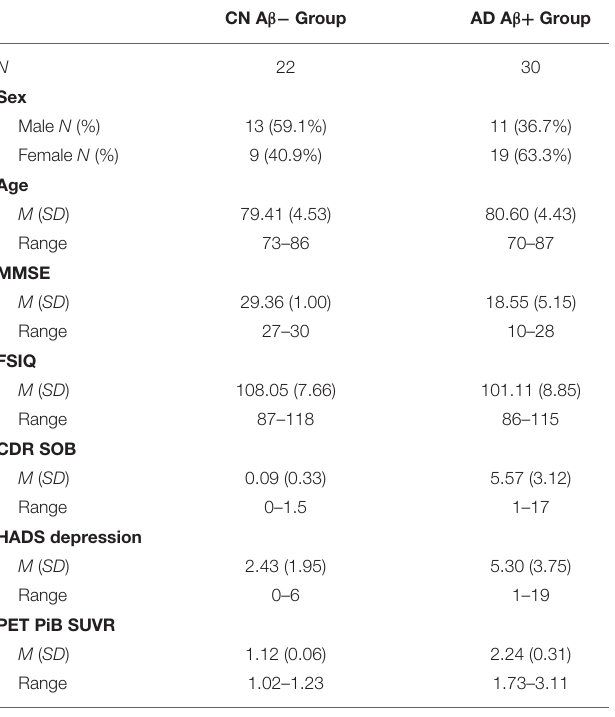
TABLE 3 | Demographic, Neuropsychological, and Biomarker characteristics of CN A β − and AD A β + groups.